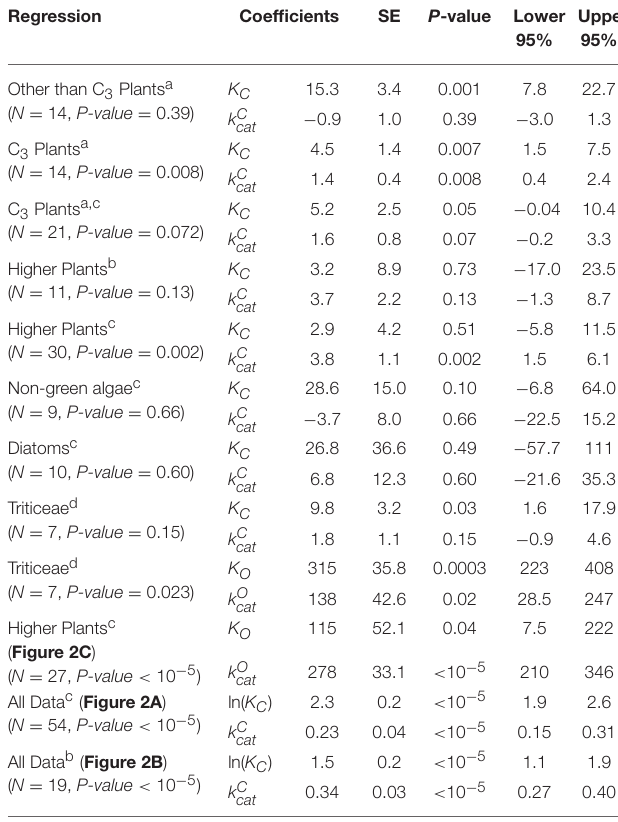
a Data from Table 1 in Galmés et al. (2014) b Table 1 Savir et al. (2010) c Table 1 d 25 ◦ C data from Table 2 in Prins et al. (2016)